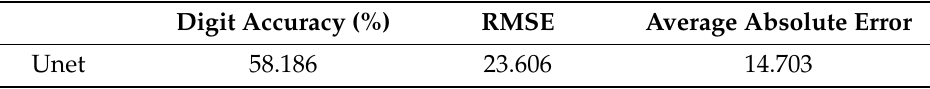
Table 3. The digit detection results are